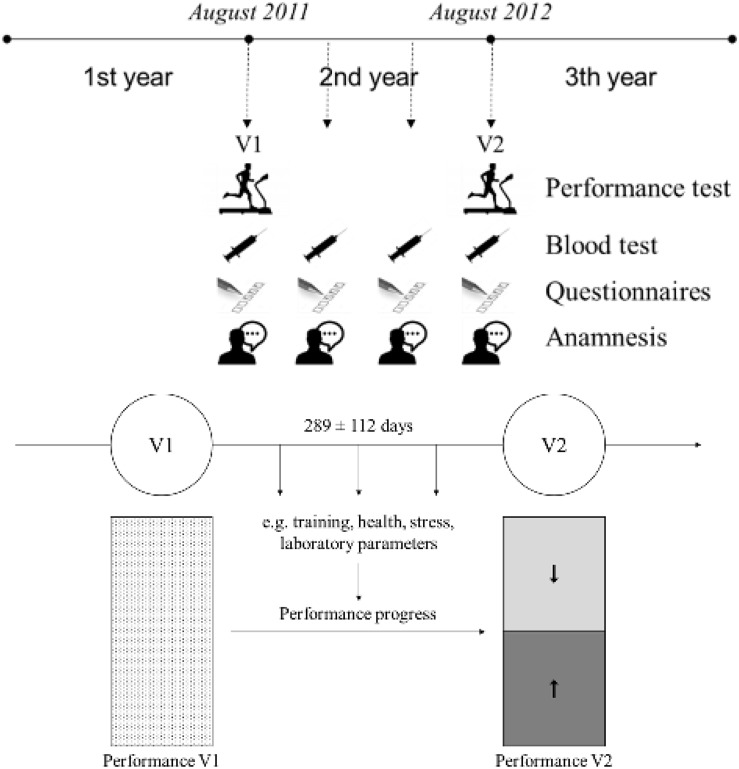
Study design: exercise intervention period. V1, Visit 1 (e.g., SOC: August 2011); V2, Visit 2 (e.g., SOC: August 2012).